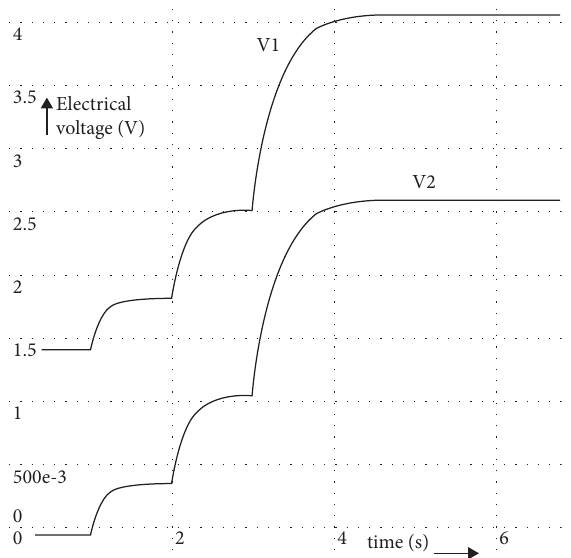
Figure 5: The results of transient analysis plugged into an electrical bridge with a photosensitive element.